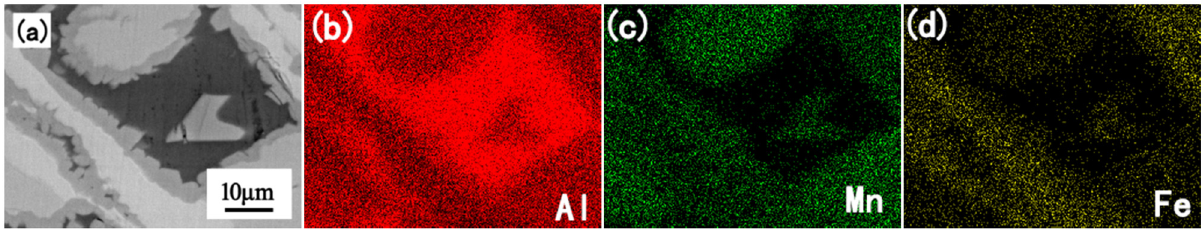
Figure 8: Microstructure morphology ( a ) and SEM - EDS elemental map showing the distribution of Al ( b ) Mn ( c ) and Fe ( d ) of Al – Mn – Fe alloy in the as - cast state.